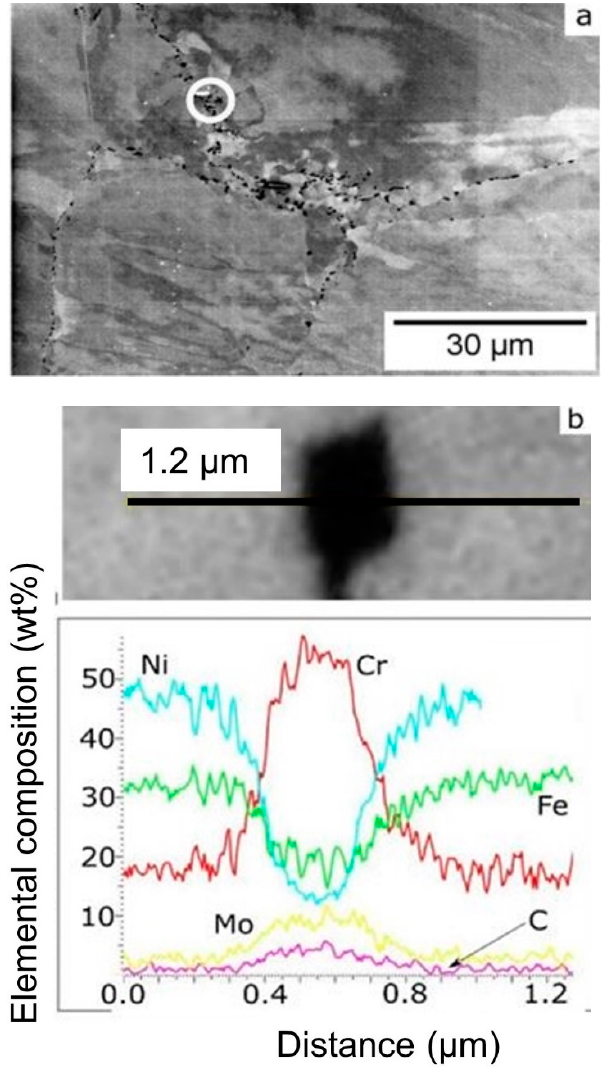
Figure 7. ( a ) SEM image of the as-stabilized microstructure of sample C ( b ) SEM image and EDS line scan data acquisition across the precipitate indicated. Examples of precipitates rich in chromium, molybdenum and iron are highlighted by the open circle.